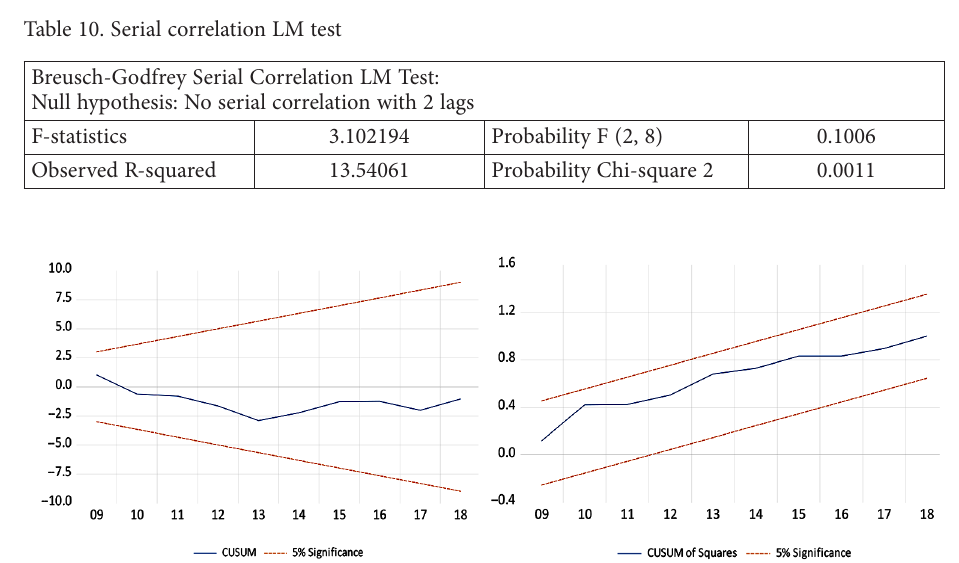
Table 10. Serial correlation LM test